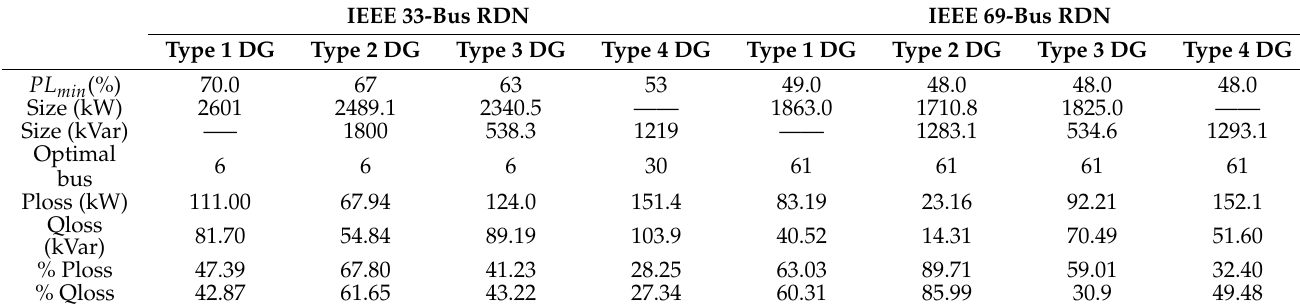
Table 6. Optimal allocations deduced for the DG Types.